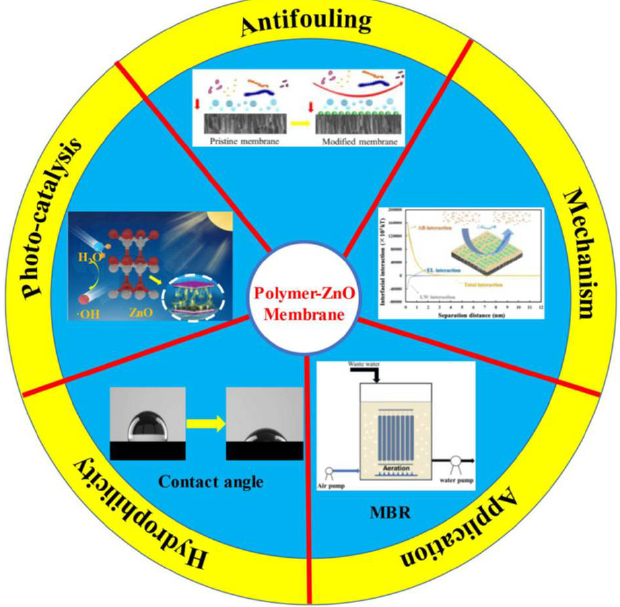
Figure 23. The study and applications of polymer-ZnO membranes [125].